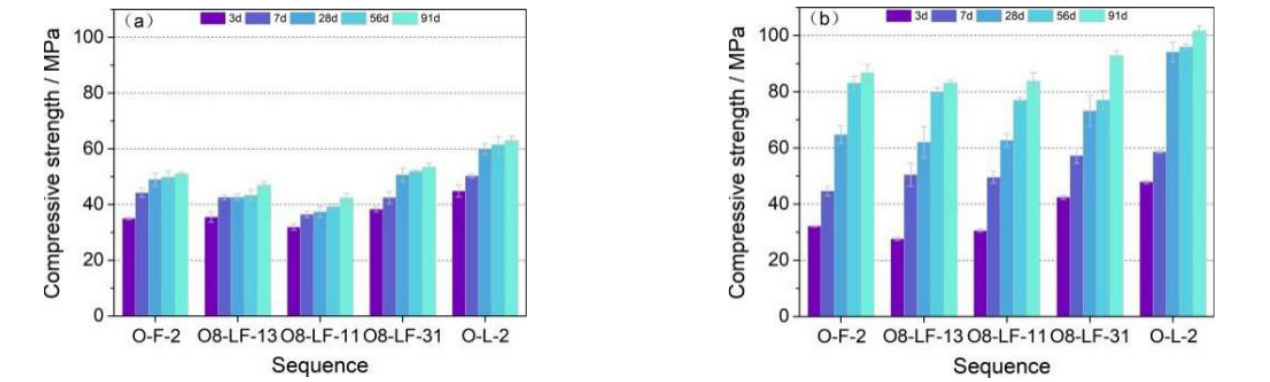
Figure 9. Compressive strength of OPC-LCFA-FA (20% LCFA + FA) samples. ( a ) Dry. ( b )